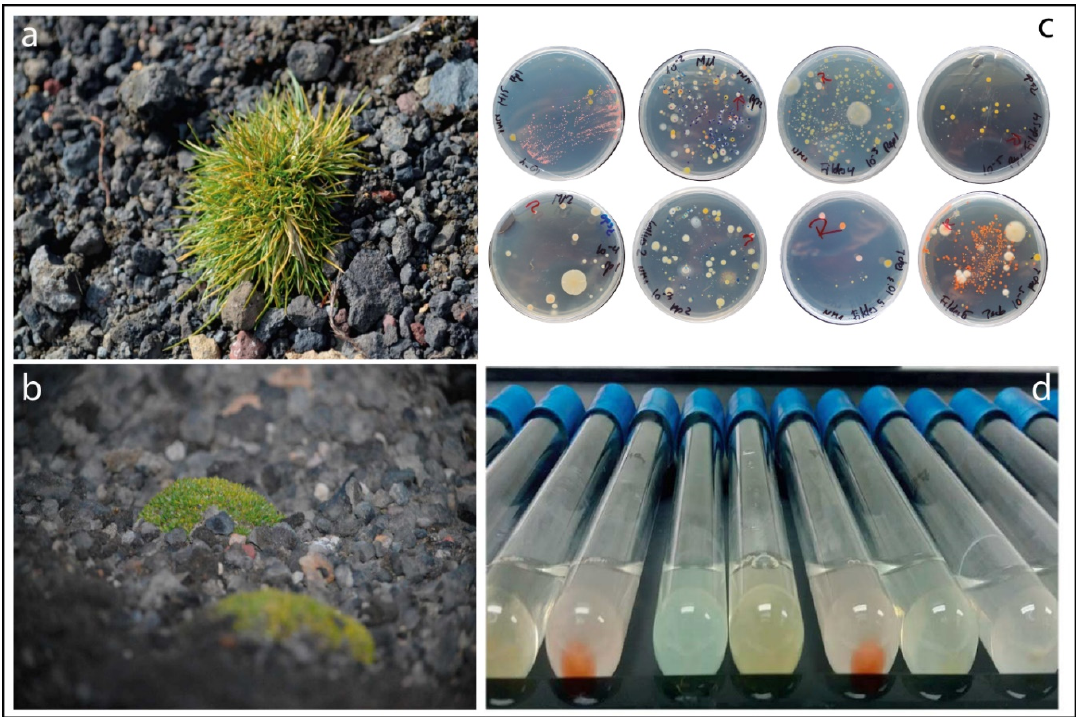
Figure 1. Specimens of ( a ) Deschampsia antarctica and ( b ) Colobanthus quitensis grown in Antarctic lands. ( c ) Example of phenotypic bacterial diversity isolated from plant niches. ( d ) Growth of putative 1-aminocyclopropane-1-carboxylate (ACC)-degrading bacteria in minimal medium supplemented with ACC as the sole source of nitrogen.